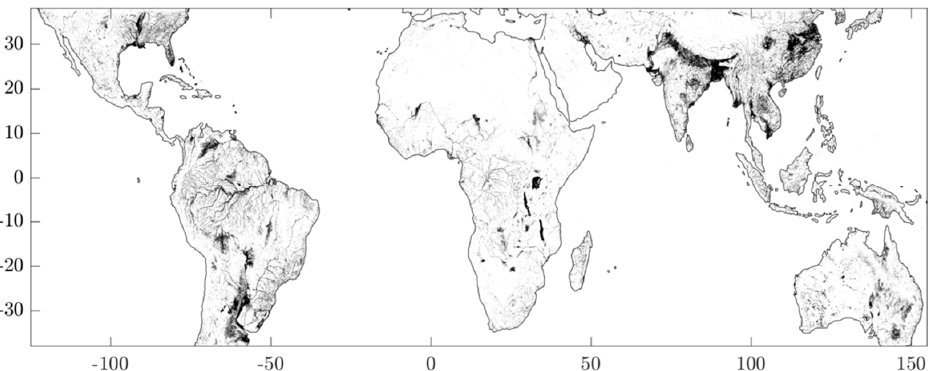
Figure 6. The 1 − km land water body mask derived from CYGNSS L1 coherence-detection by M. Al-Khaldi et al. The map was generated using 1 year of CYGNSS data.